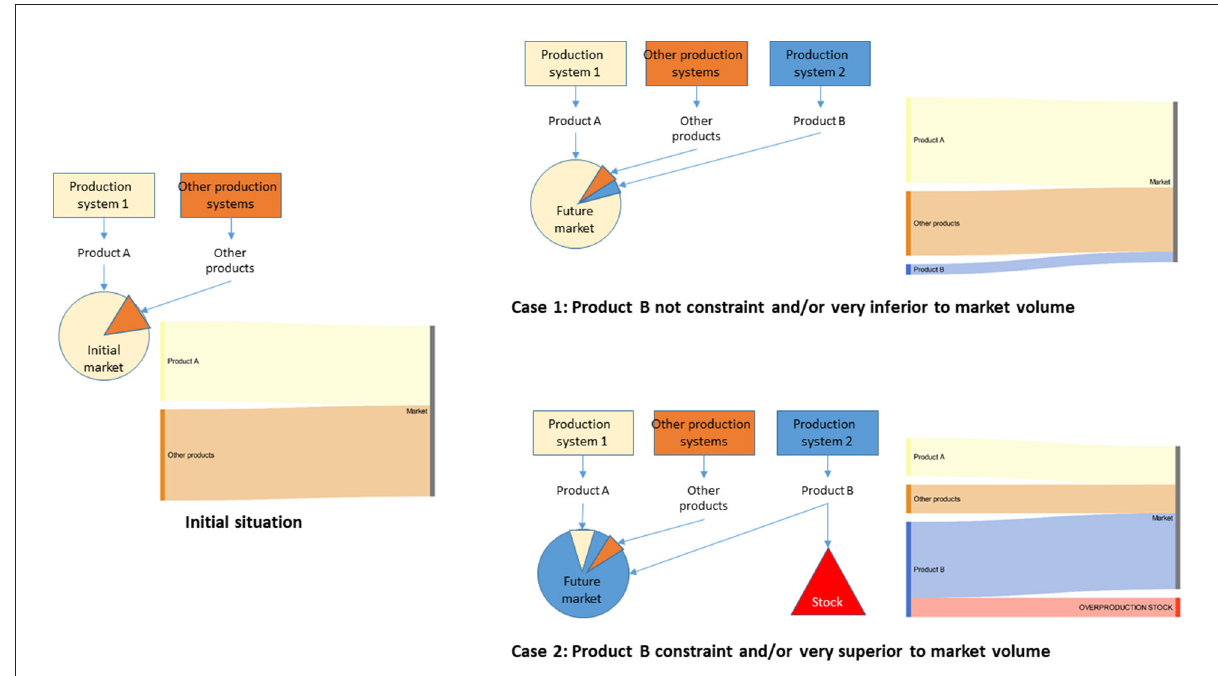
FIGURE3 MFA and downstream changes in flows according to offer and